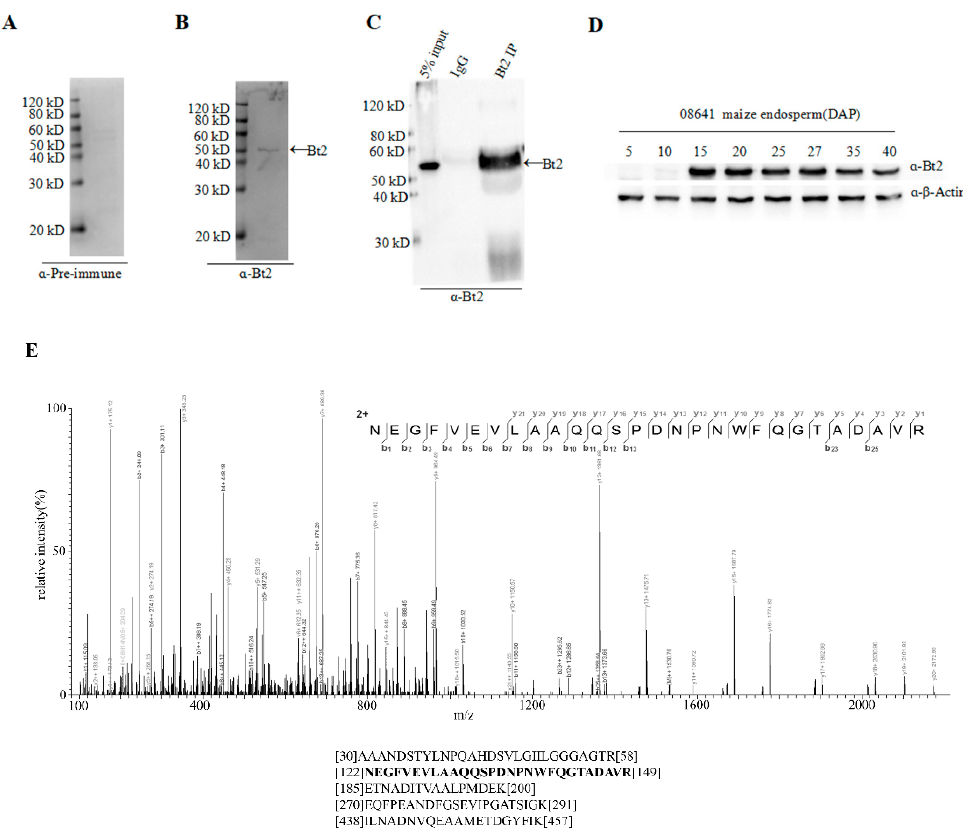
Figure 3. Immunoprecipitation of stromal proteins and expression analysis of Bt2 in maize endosperm. ( A ) Pre-immune serum was evaluated as control with 20 DAP maize endosperm. Ratio of antibodies